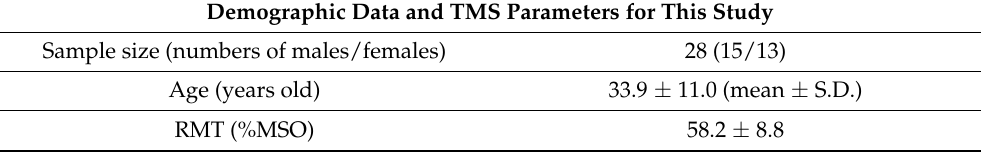
Table 1. Summary of demographic data and TMS parameters of the participants. RMT: resting motor threshold. MSO: maximum stimulator output; S.D.: standard deviation. Demographic Data and TMS Parameters for This Study Sample size (numbers of